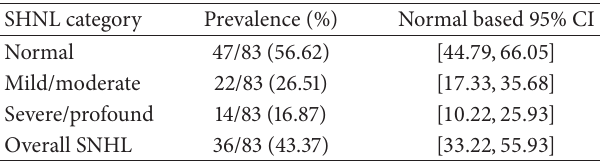
Table 3: Prevalence of